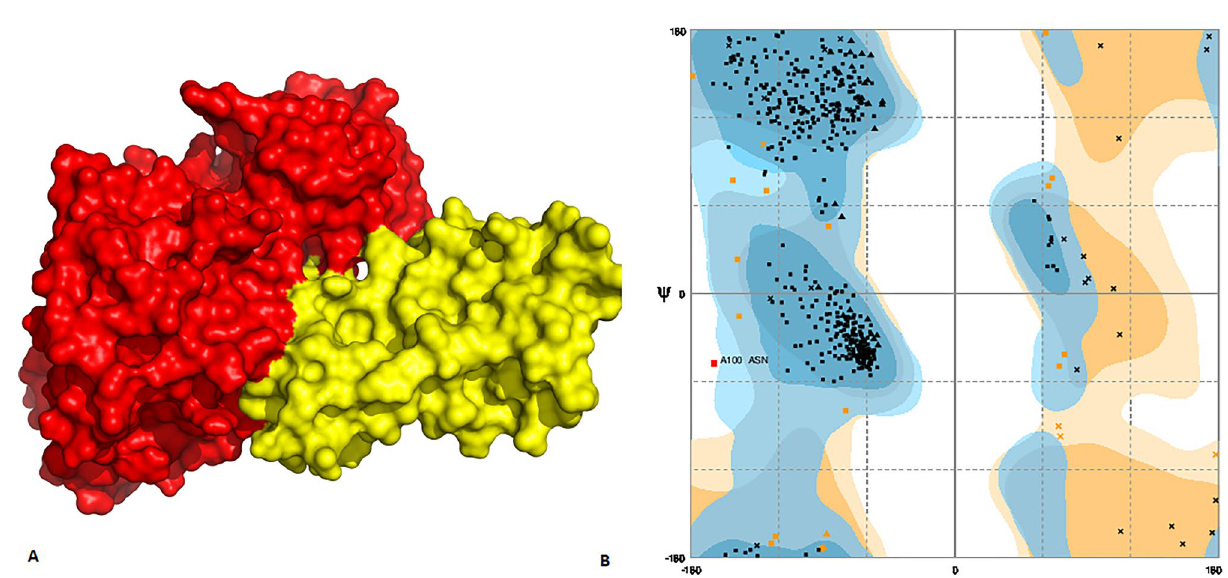
Figure 6. ( A ) Docked complex of HCV NS5A and p38 MAPK. Red color represents p38 MAPK while yellow signifies NS5A ( B ). Ramachandran plot shows allowed and disallowed